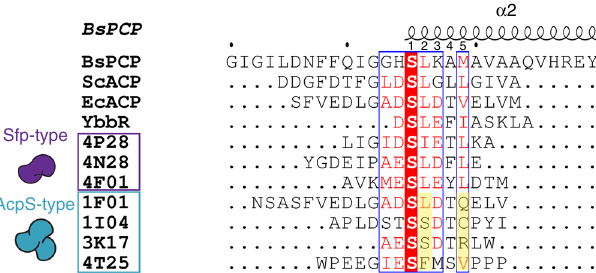
Fig. 4 Sequence alignment of hit peptides relative to native PPTase substrates. The sequence alignment for B. subtilis PCP, S. coelicolor ACP, E. coli ACP, YbbR peptide, compared to Sfp-type peptide hits (4P28, 4N28, 4F01) and AcpS-type peptide hits (1F01, 1I04, 3K17, 4T25) to the secondary ( α 2) structure of B. subtilis PCP (PDB: 4MRT). The blue box and red residues show general conserved sequences across all the peptides. The majority of AcpS-type peptides have conserved polar residues in position 2 and 5 (highlighted in yellow). The peptide identi fi cation corresponds to the round number and location it was identi fi ed from (round number_letter row_spot number on membrane) during the iterative rounds of